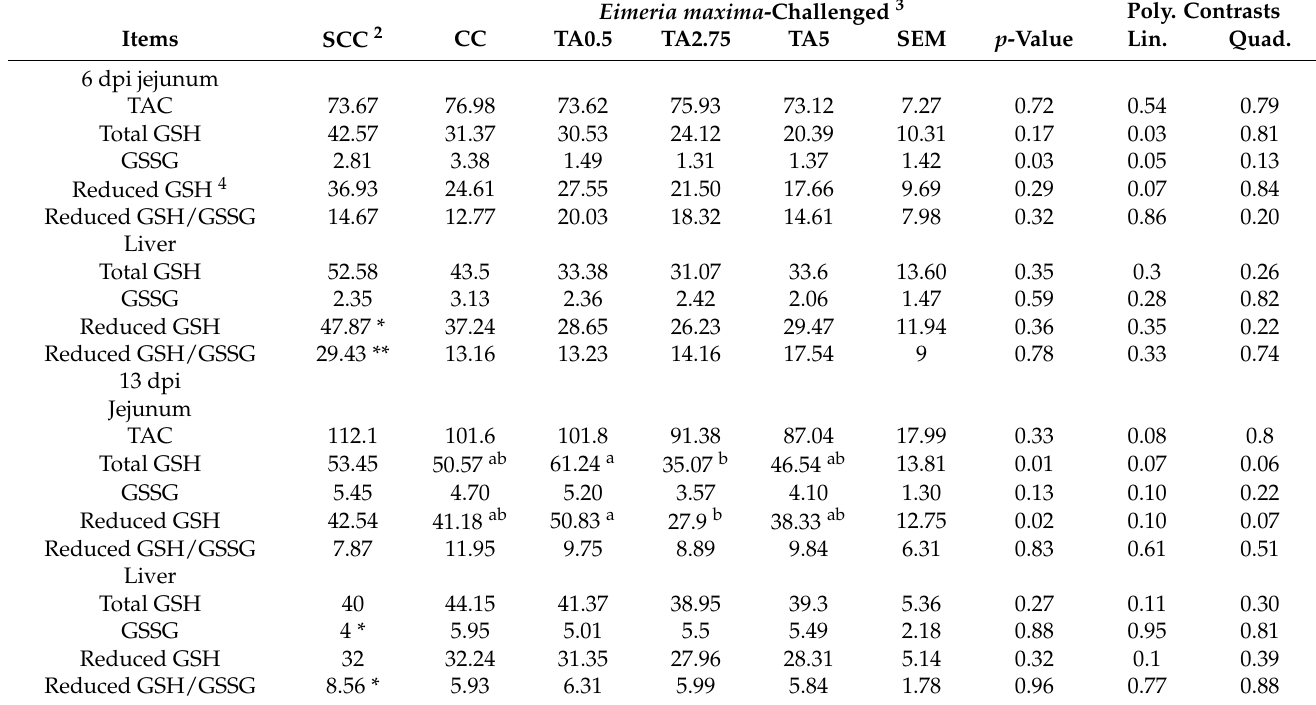
Table 7. Effects of tannic acid supplementation on total antioxidant capacity (TAC) in the jejunum and glutathione (GSH), oxidized GSH (GSSG), reduced GSH, and the reduced GSH/GSSG ratio in the jejunum and liver at 6 days post-infection (dpi) and 13 dpi in broiler chickens infected